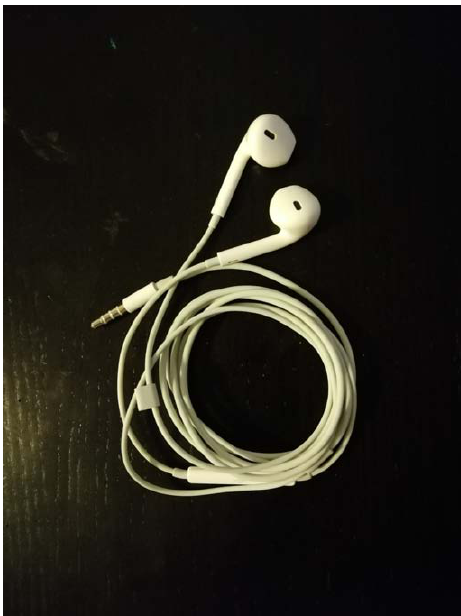
Figure 4. Auricolari per smartphone, 2020; © Gabriela Diaz